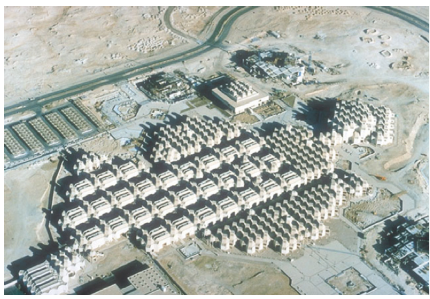
Figure 3: Aerial view of Qatar University campus: early stages of implementation.